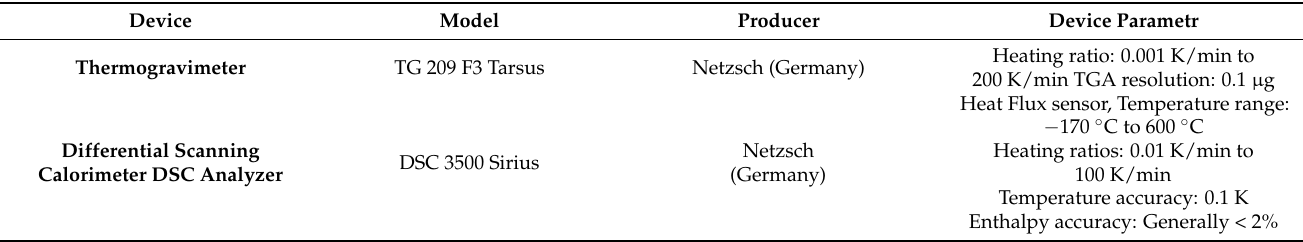
Table 6. Equipment used in experimental research on the Miscanthus torrefaction process. Device